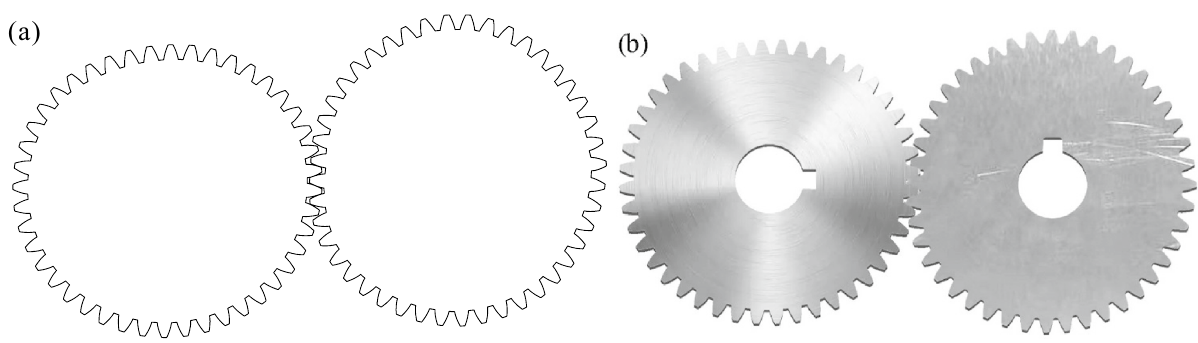
Figure 6. Three-segment deformed elliptical gear pair. ( a ) Transverse section. ( b ) Gear pair manufactured through wire-electrode cutting, and the background of them is deducted using Adobe Photoshop